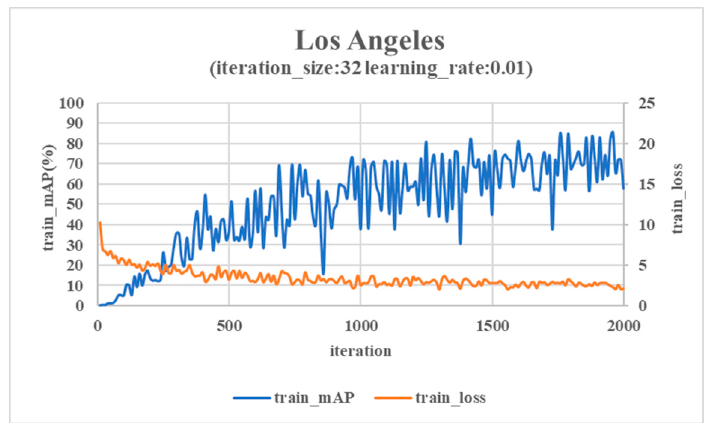
Figure 14. mAP and loss variation of the Los Angeles training data set when the rate of learning is 0.01.